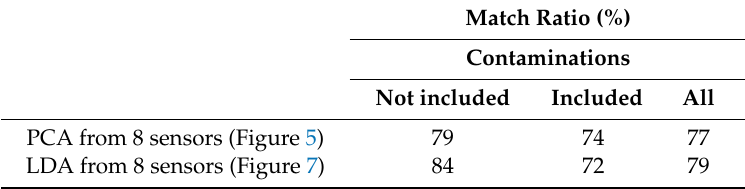
Table 4. Weighted average of match ratios from PCA and LDA from eight